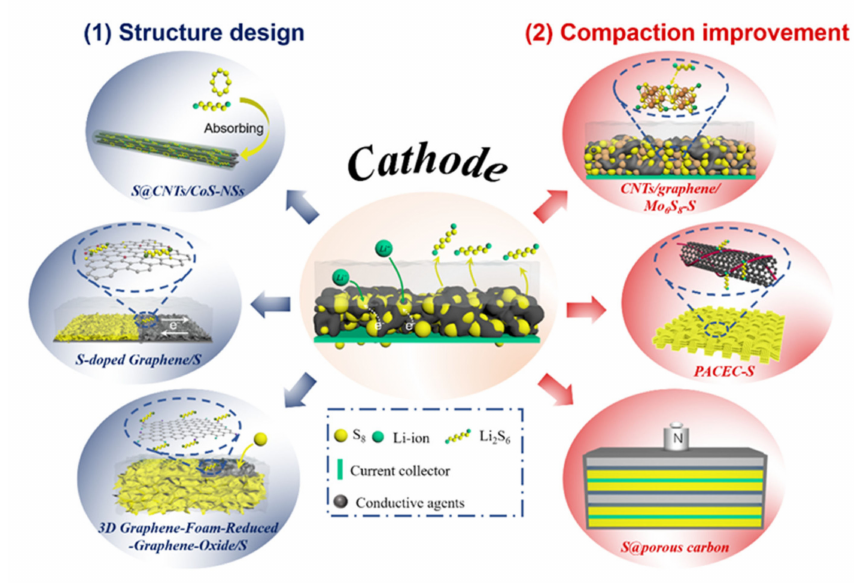
Figure 2. Composite cathode issues in Li–S batteries include low S loading/utilization, large volume change during cycling, poor compaction density, polysulfide dissolution, and limited electronic/ionic conductivities. Corresponding strategies for enhancing cathode composite architecture to improve electrochemical performance include ( 1 ) decorating nanosized sulfur in a robust hierarchical conduc- tive matrix and ( 2 ) improving compaction with polar radical compounds, functional binders, and external stacking